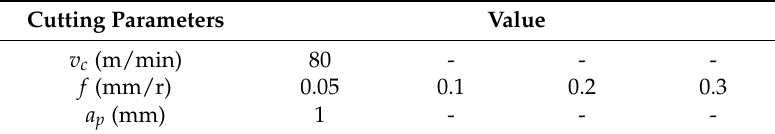
Table 3. Cutting parameter values used in turning tests.